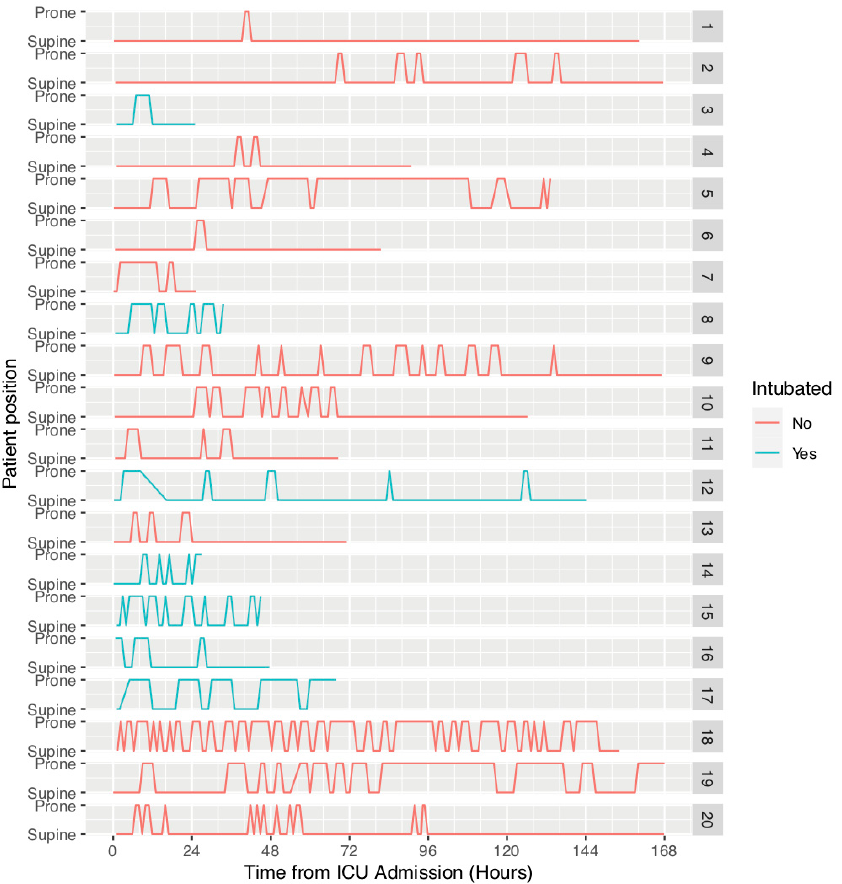
Figure 1. Time spent prone vs time spent supine (hours) for each patient throughout their admission. Patients that failed non-invasive ventilation and required invasive mechanical ventilation (NIV+IMV group) are shown in blue and non-invasive ventilation (NIV) only group in